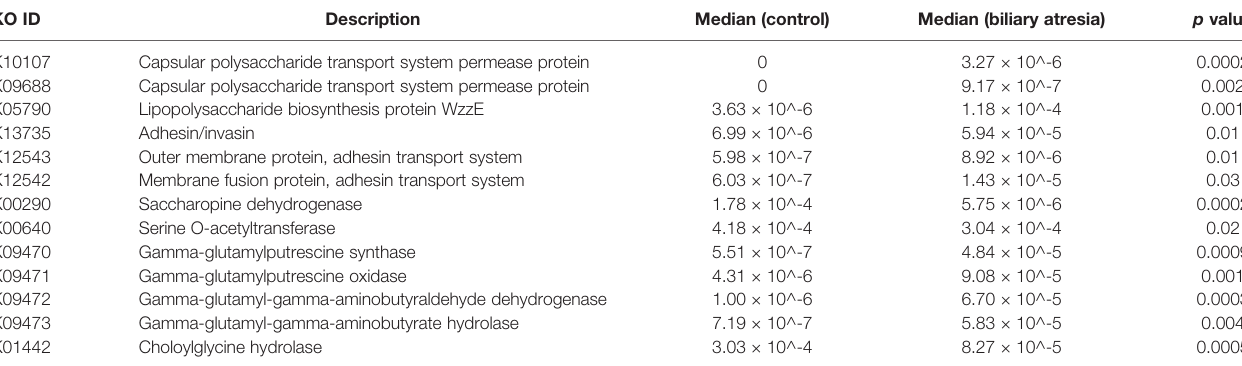
TABLE 1 | Elevated or decreased gut microbiome ’ s functional pro fi les in biliary atresia individuals. KO